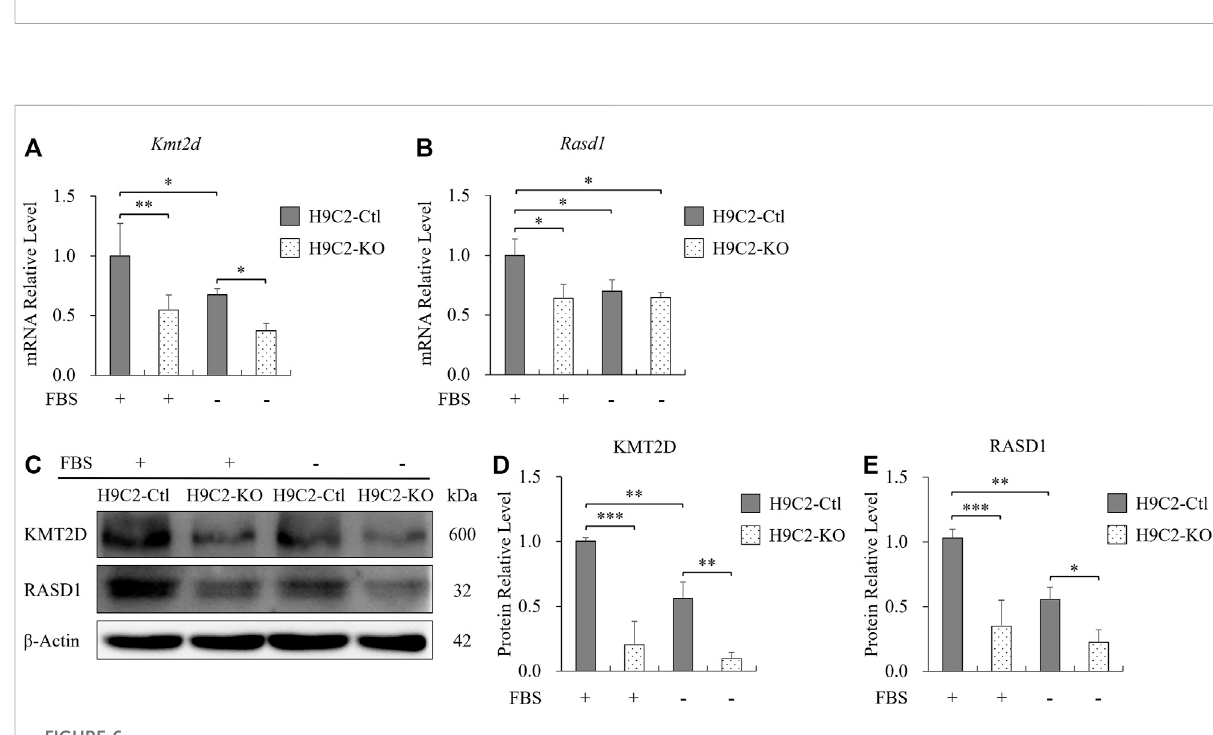
FIGURE 6 The decreased expression of Rasd1 was caused by serum de fi ciency. (A,B) qPCR analysis for Kmt2d (A) and Rasd1 (B) in FBS or FBS-free conditions in H9C2 cells. (C) Representative images of western blots for KMT2D and RASD1 in FBS or FBS-free conditions in the H9C2-Ctl and the H9C2-KO cells. (D,E) Quantitativeanalysis ofKMT2D (D) and RASD1 (E) expression intheH9C2-Ctl and theH9C2-KOcell.( n =3ofeachgroup;* p < 0.05, ** p < 0.01, *** p <